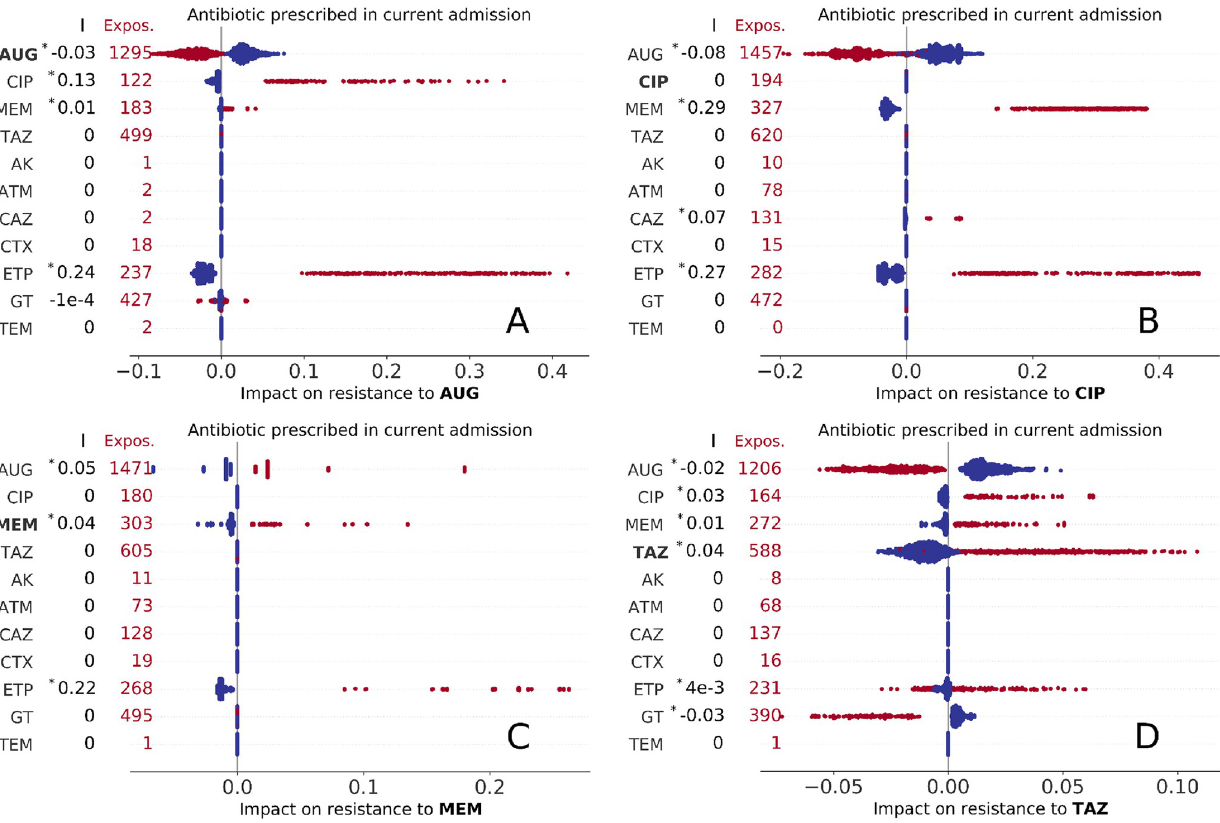
Fig 2. Impact of present use of antibiotics on resistance to AUG, CIP, MEM, and TAZ treatment (A,B,C, and D panels, respectively). Each marker represents an admission event, with colour red indicating exposure to the treatment and total number of treated episodes reported on the left for each drug. The corresponding Shapley values are represented as horizontal coordinates. Values of the slope index I are reported as measures of the direction and strength of association of the factor with AMR outcome (see also Table E in S1 Text, asterisk ( � ) indicates statistical significance, P < 0.01).